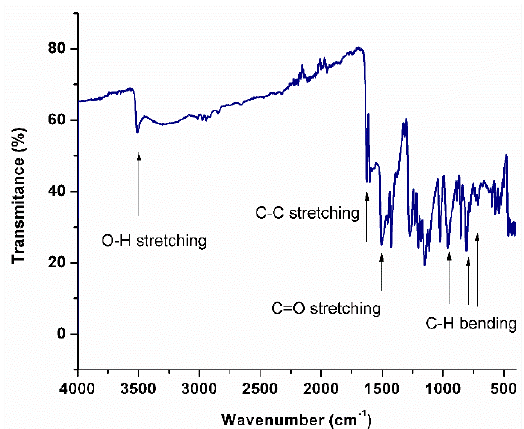
Figure 5. Fourier transform infrared spectroscopy of curcumin. Characteristic bands of the molecule are indicated with arrows.